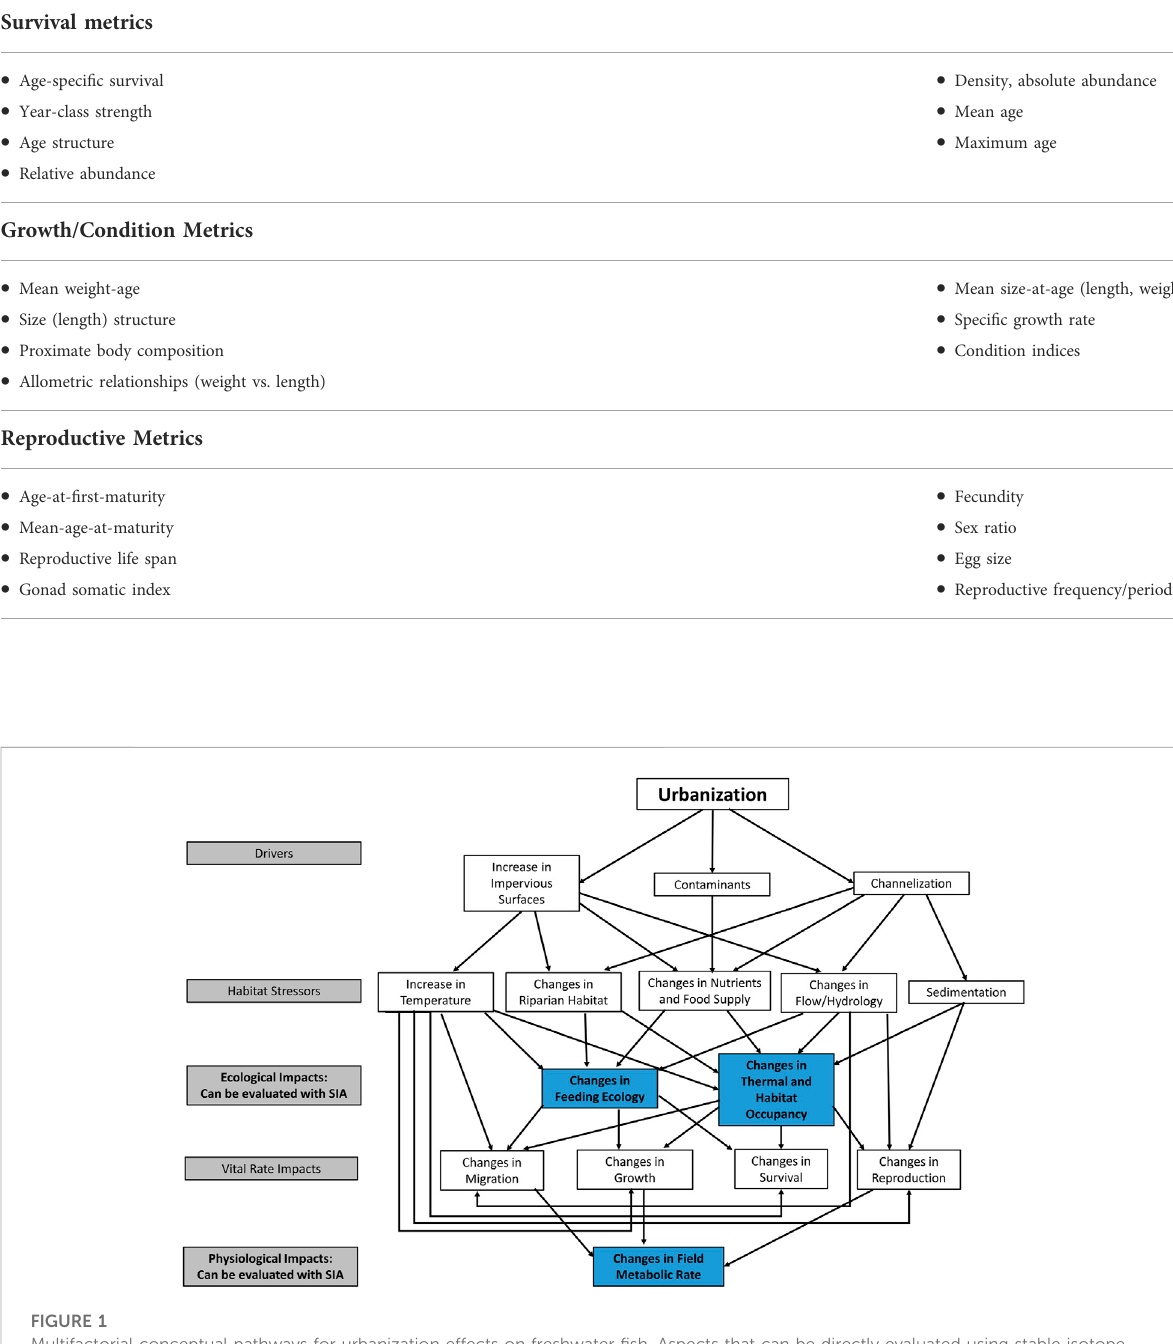
TABLE 1 Traditional metrics used to assess fi sh population status based on Power (2002). Metrics can be derived from survey measurements of the population from either point-in-time cross-sectional surveys or from repeated surveys through time. Metrics are grouped by the key vital rates (survival, growth or reproduction) responsible for determining the intrinsic rate of population increase. The measures within each group are not necessarily independent of each other either within or between categories. As an example, changes in maximum age (survival) will affect age- structure similarly used to assess survival. This can hold direct implications for life-time fecundity (reproduction) and may affect age-speci fi c survival rates (survival) in subsequent generations. Stable isotope-based approaches can be used to understand changes in feeding ecology, habitat use, and temperature use that might lead to changes in vital rates.